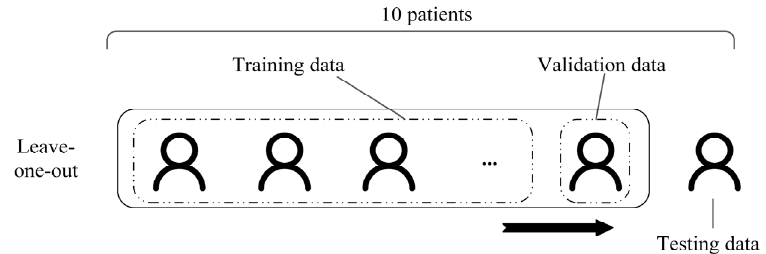
Figure 3. Leave-one-out cross-patient validation.